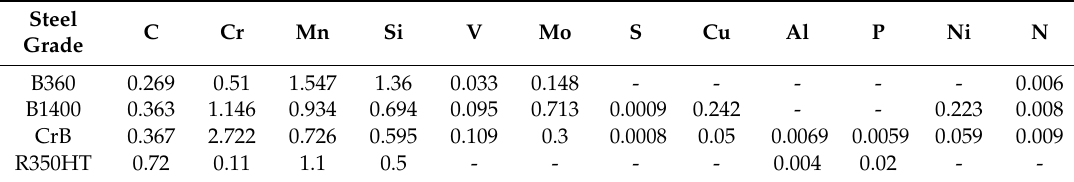
Table 1. Chemical composition of steels in (wt